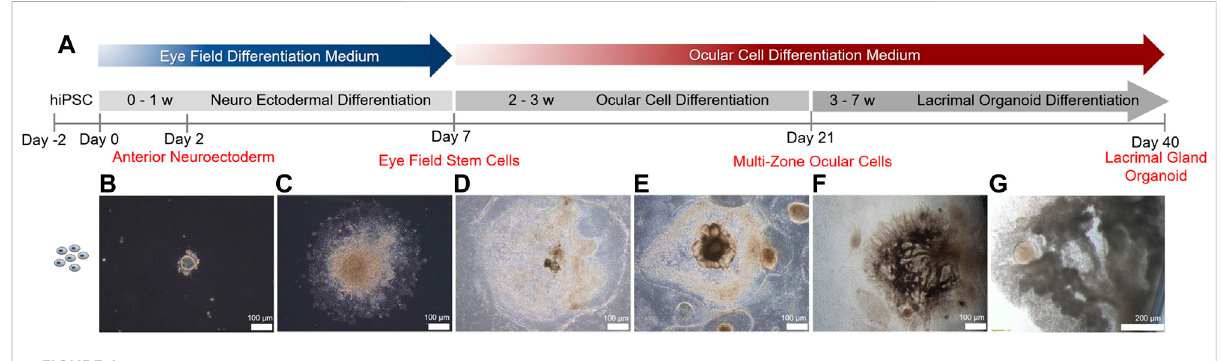
FIGURE 1 Timeline of lacrimal gland organoid differentiation from human